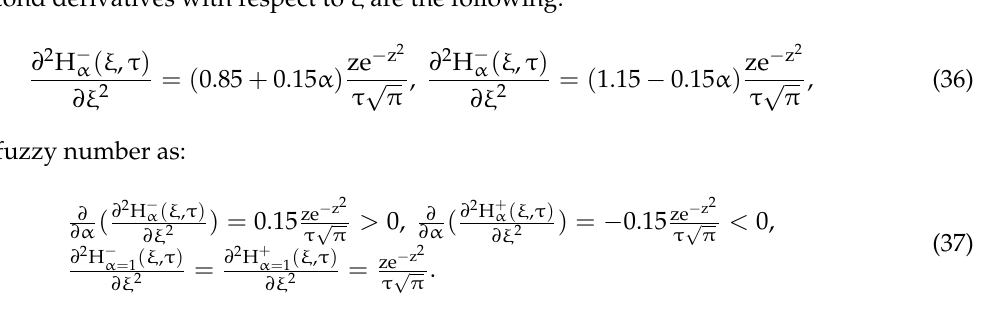
Figure 3. First derivative with respect to τ .